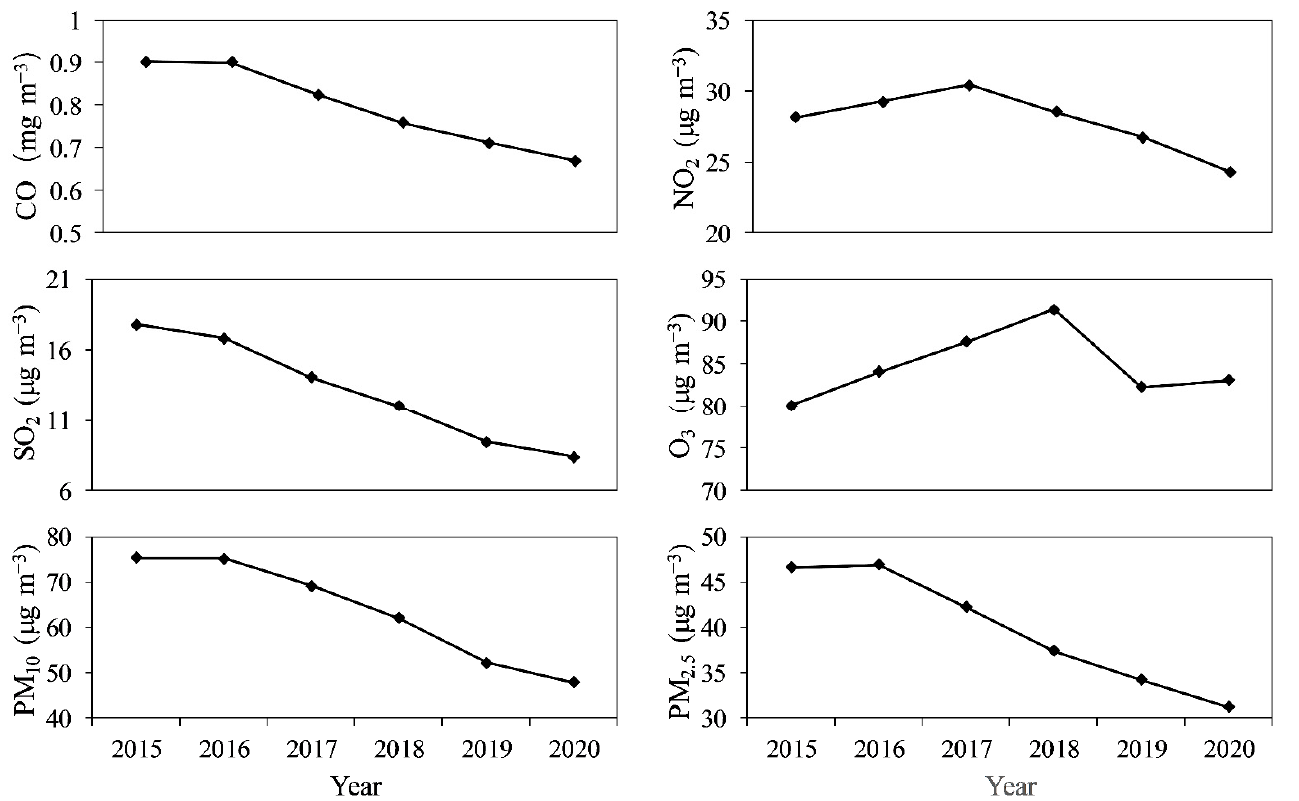
Figure 3. Annual average concentration trend of the six pollutants.